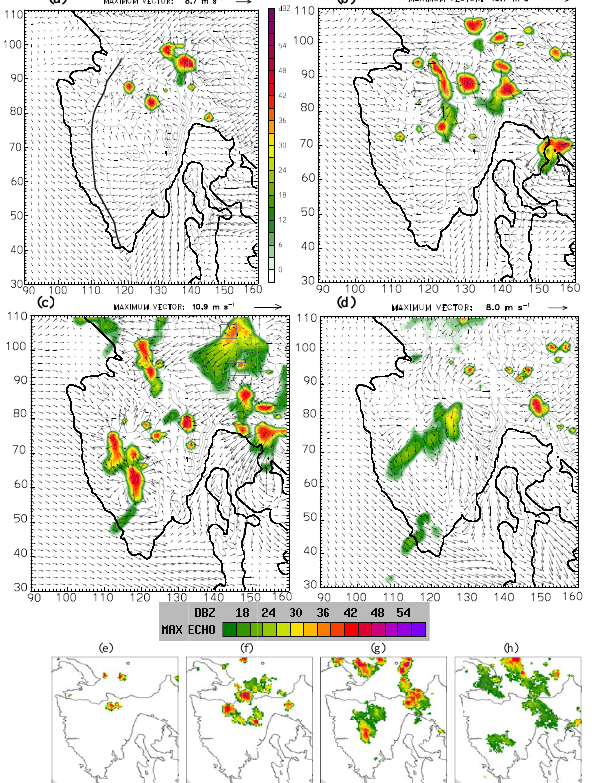
Fig. 4. (a – d) Diurnal evolution of the modelled near-surface wind (in ms − 1 , at 10ma.g.l.) associated with the maximum simulated equivalent radar reflectivity factor (dBZ) on 9 July 2006 at (a) 10:00CET, (b) 11:00CET, (c) 14:00CET and (d) 16:00CET. Wind vectors are depicted on every second grid point (reference length in the upper right corner-hand corner). The thick black solid line in (a) indicates the position of the main convergence zone. (e – h) Radar reflectivity factor (dBZ) in radar images (source: ARSO – www.meteo.si) on 9 July 2006 at (e) 11:00CET, (f) 12:30CET, (g) 13:30CET and (h) at 14:30CET. The radar reflectivity is given with a 3dBZ interval.